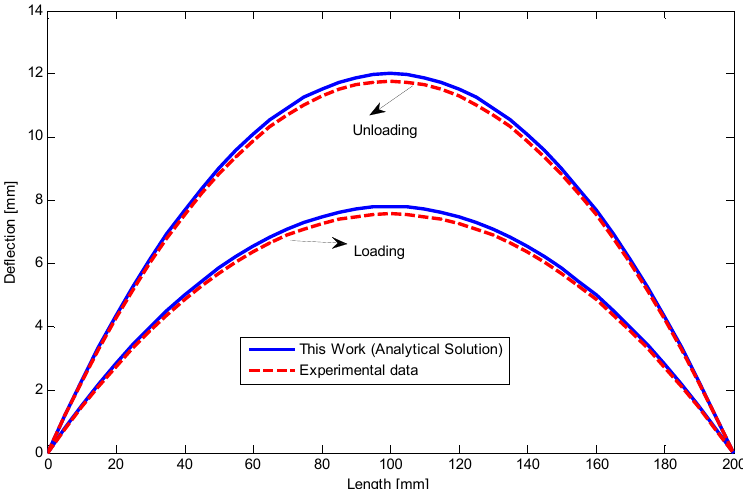
Figure 25. The relationship between deflection and length at the end of loading and unloading for the circular SMA beam under four-point bending test with the force about 19 kN.